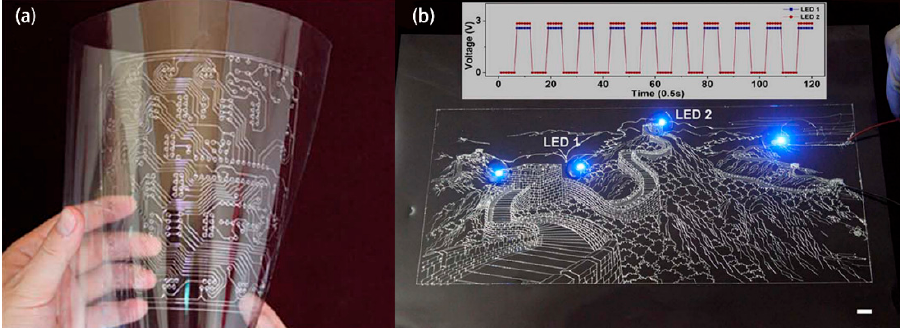
Figure 2. Direct-printed functional electronic patterns composed of liquid metal wires on a polyvinyl chloride (PVC) substrate for integrated circuit (IC) application: ( a ) the printed circuit board (PCB) that can be folded; ( b ) the “Great Wall” pattern with illuminated light-emitting diodes (LEDs). Reproduced from Zheng et al. [57] under Creative Commons Attribution-NonCommercial-ShareAlike 3.0 Unported license.